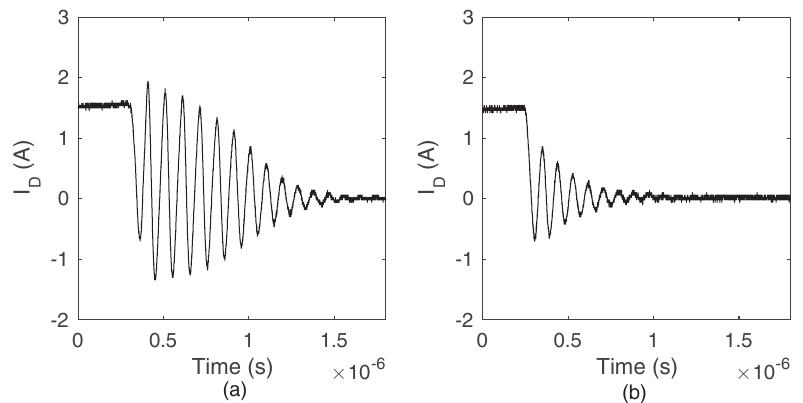
Figure 22. The experimental type II oscillation waveforms of the drain current I D with L C = 460 nH and L G = 22 nH. ( a ) R G = 2 Ω . ( b ) R G = 3 Ω